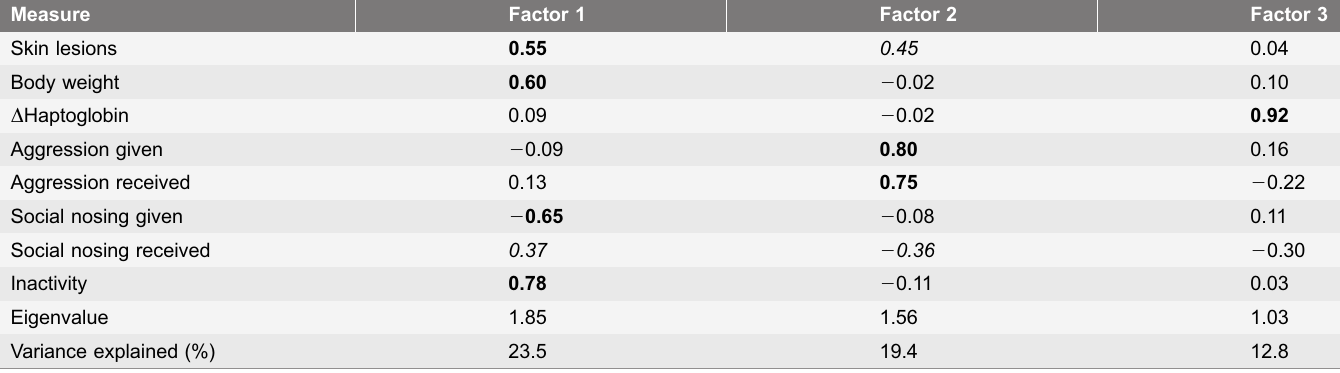
Table 1. Loadings on the factors extracted by the principal component analysis, after orthogonal rotation, of variables recorded on individual